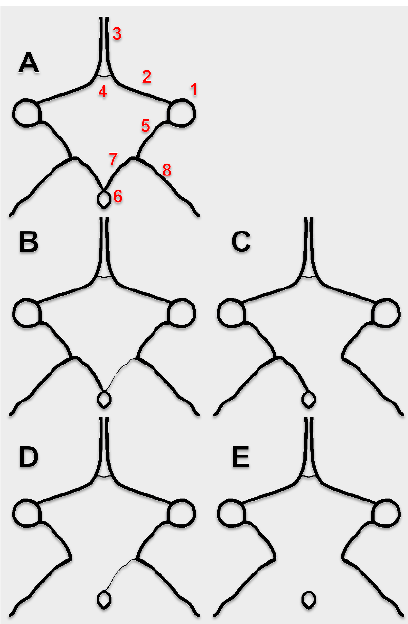
Figure 1. Superior views of the circle of Willis. ( A ). Complete circle of Willis. ( B ). Partial fetal posterior cerebral artery (p-FPCA), with hypoplastic P1 segment of the PCA. ( C ). Full/complete fetal posterior cerebral artery (f-FPCA), with aplastic P1 segment of the PCA. ( D ). Bilateral fetal posterior cerebral artery, p-FPCA+f-FPCA combination; ( E ). Bilateral fetal posterior cerebral artery, f-FPCA+f-FPCA combination. Other possible variations of the sides of the circle of Willis are not considered here. 1.ICA; 2.A1 segment of the ACA; 3.A2 segment of the ACA; 4.AComA; 5.PComA; 6.BA; 7.P1 segment of the PCA; 8.P2 segment of the PCA.